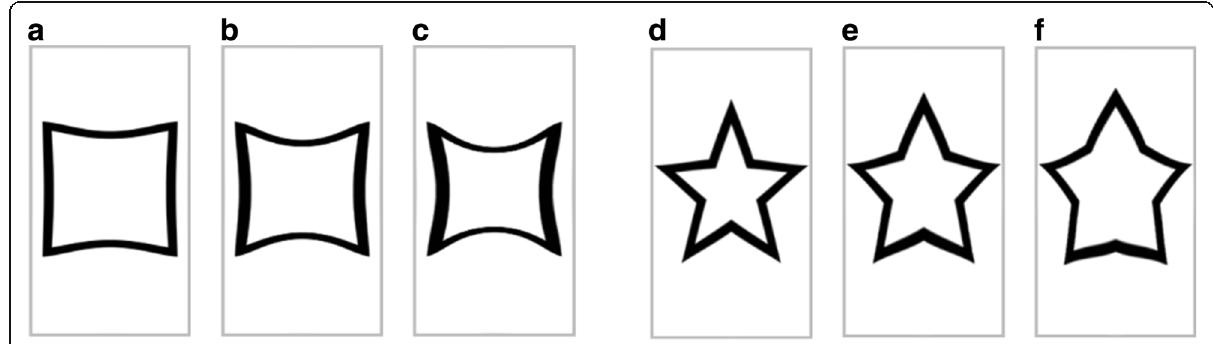
Fig. 1 Distorted symbols. a = square 30, b = square 60, c = square 90, d = star − 30, e = star − 60, f = star − 90